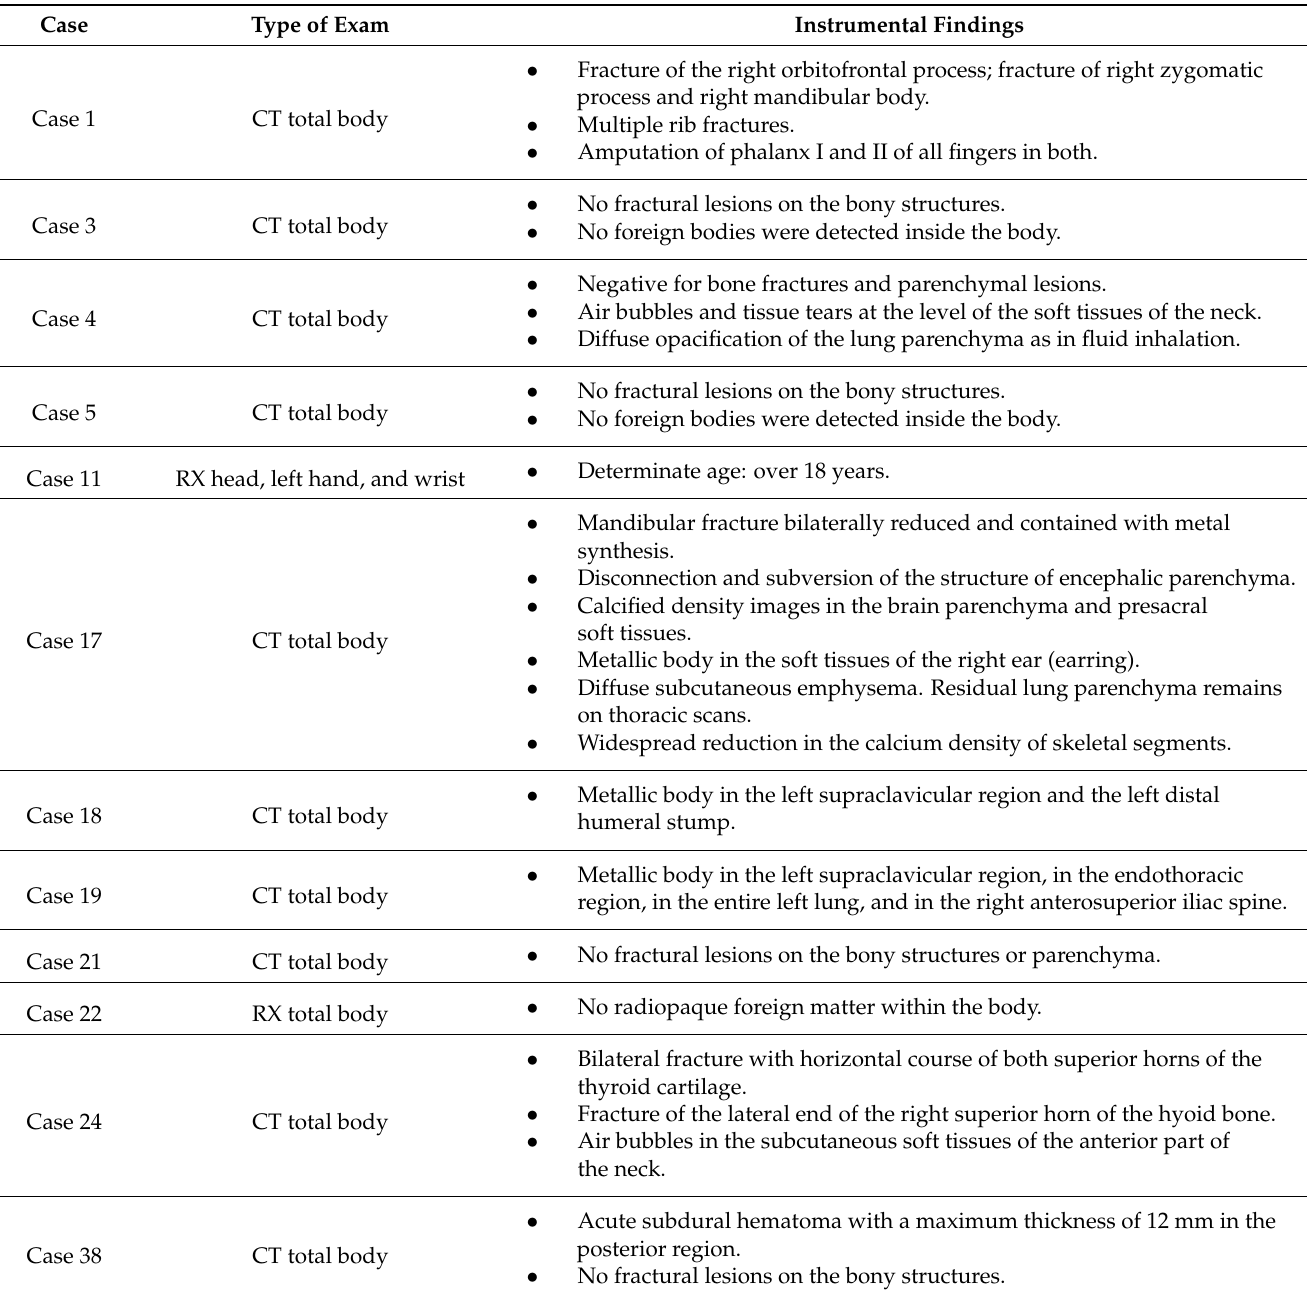
Table 3. Results of radiological exams in 82 cases of burned or charred bodies. The presence of fracture, parenchymal lesions, and metallic bodies was